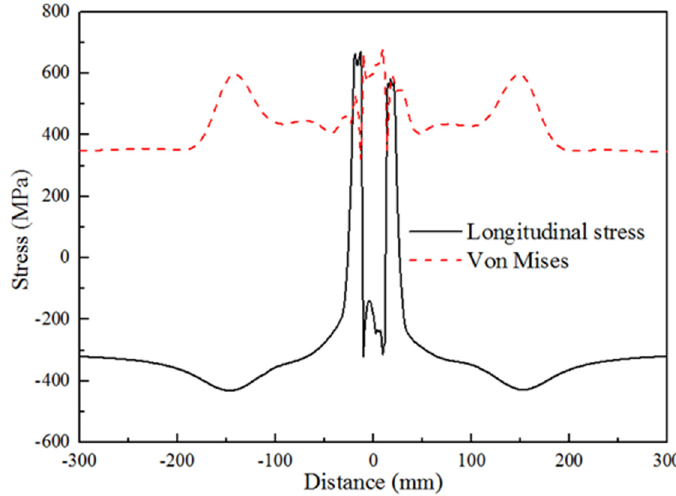
Figure 10. Residual stress-distance curve of heavy plate welded joint.